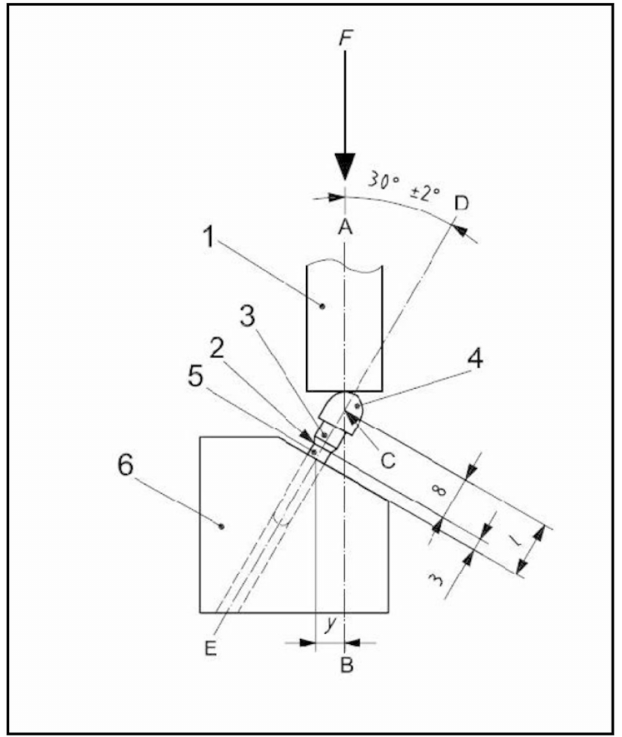
Metals 2019 , 9 , 1106